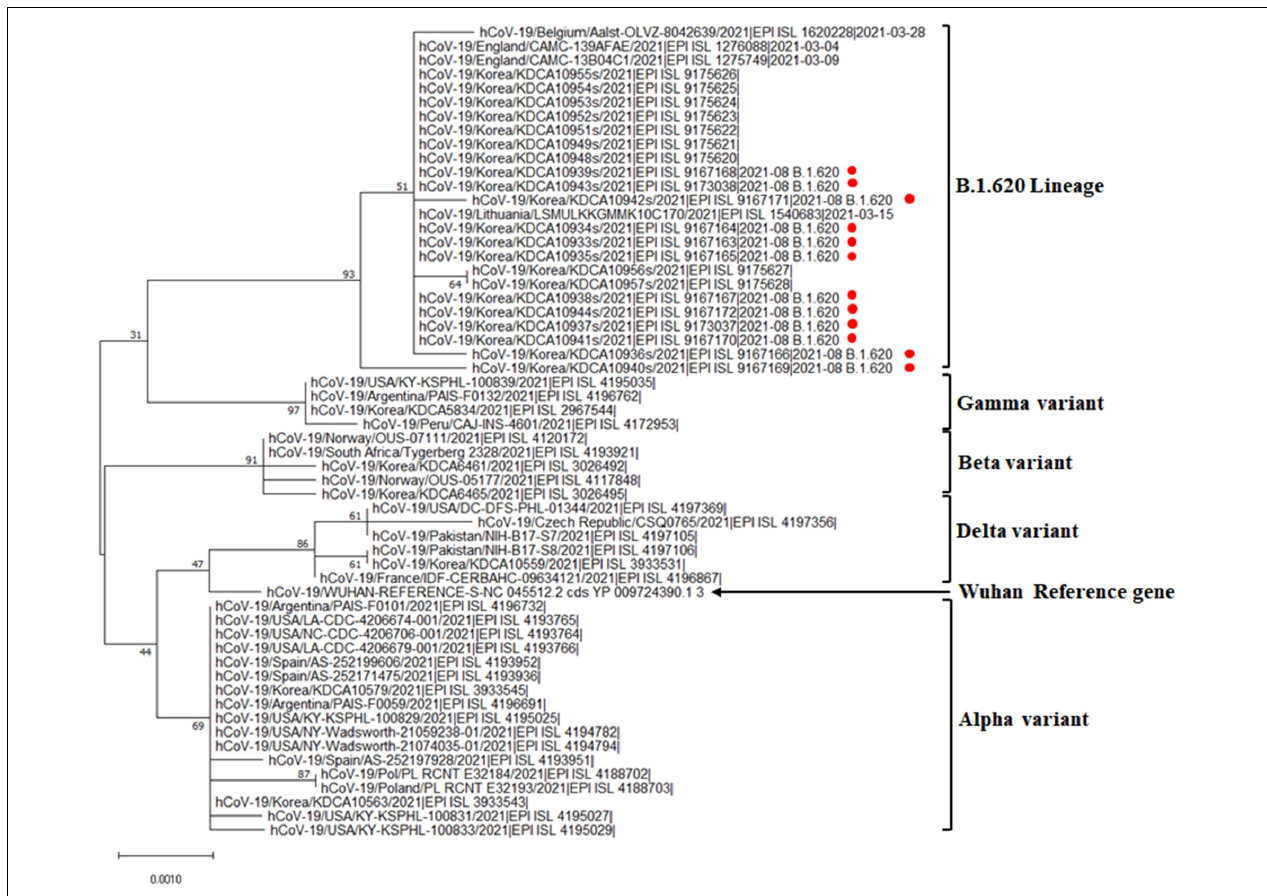
FIGURE 1 | Phylogenetic analysis of the SARS-CoV-2 B.1.620 lineage in the general hospital of Jeju Island. Phylogenetic analysis of alpha, beta, gamma, delta variants, and B.1.620 lineage with outbreak cases in Jeju Island. Red circles indicate the genomes from hospital outbreak cases in Jeju